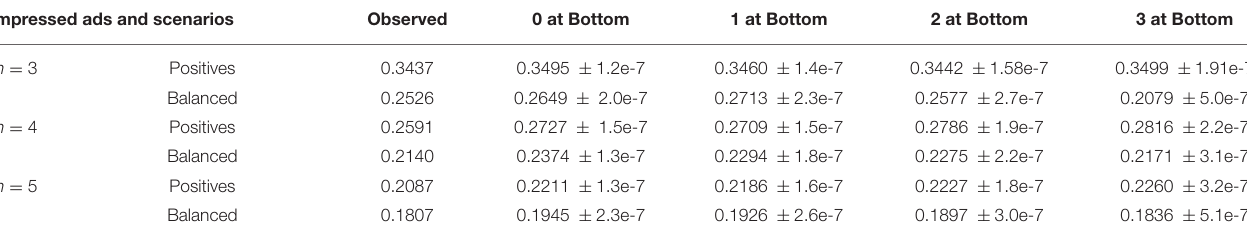
m E [ Y i ( a )], for all possible allocations. i = 1 m P